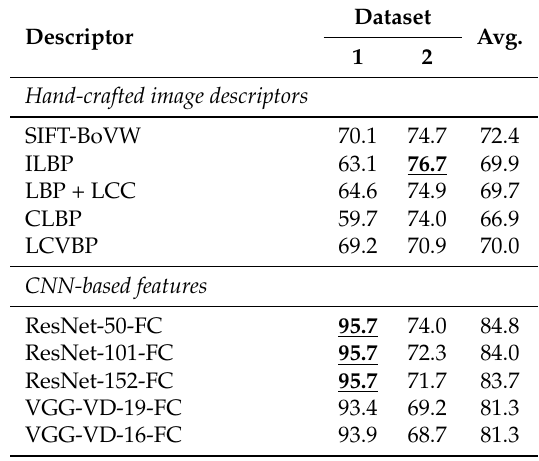
Table 10. Results of Experiment #4: non-stationary textures with variations in illumination.